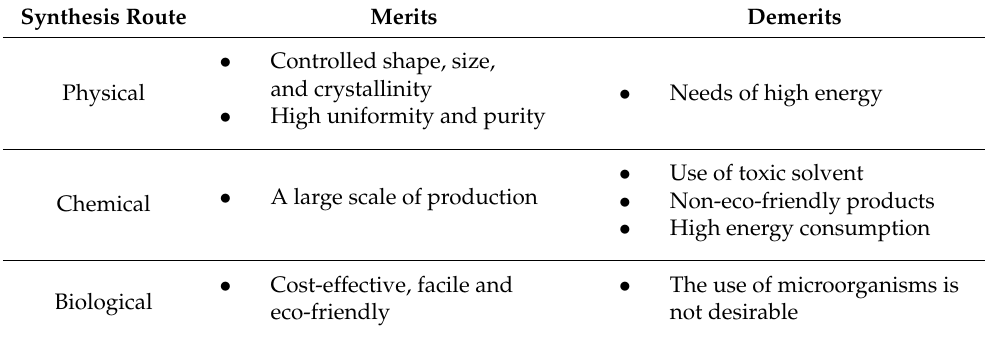
Table 9. A comparison of various synthesis methods of copper oxide nanoparticles. Elaboration from ref.